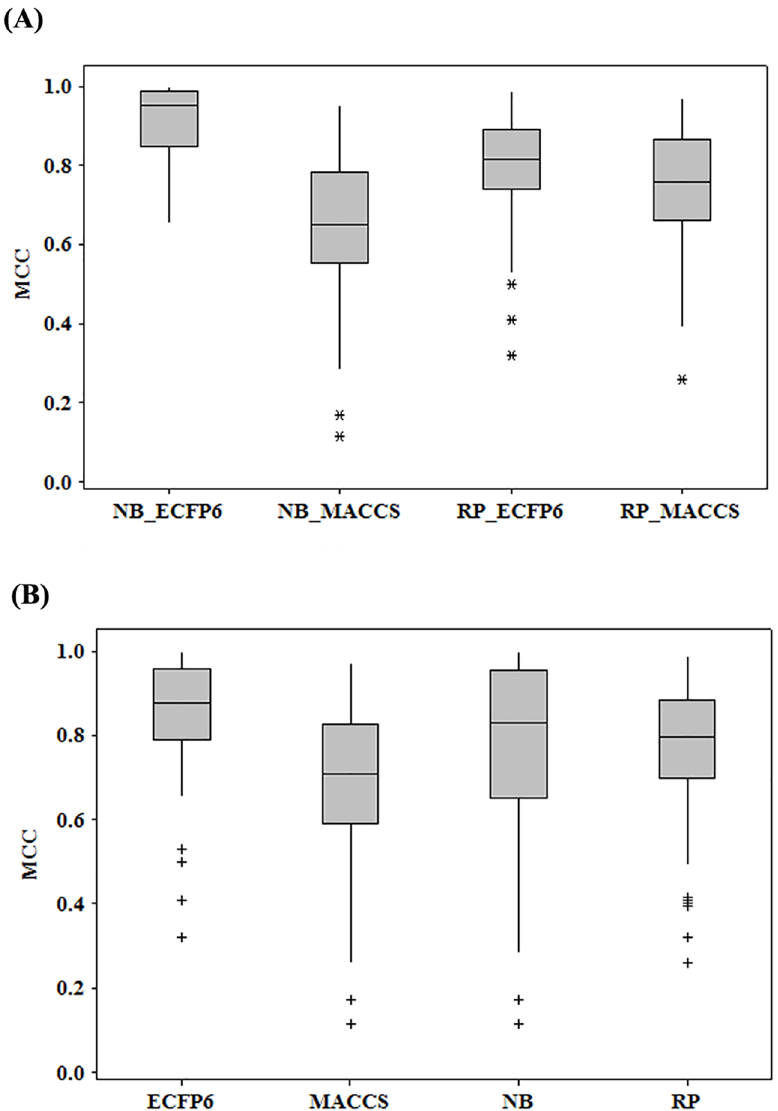
Fig 4. Boxplot shows the minimum, lower quartile(Q1), median (Q2), upper quartile(Q3), and maximum of Matthews correlationcoefficient (MCC) on test sets basedon four types of classifiers (A) and different fingerprintsand algorithms